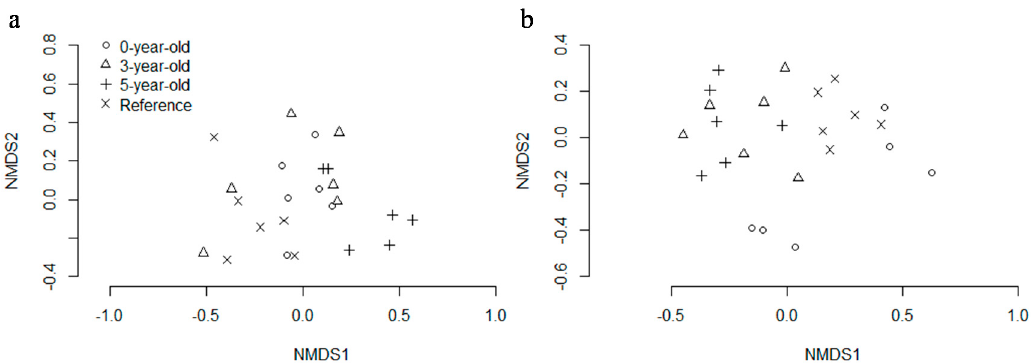
Figure 2. The NMDS ordination plot showing the species pollination traits in the ( a ) upland and ( b ) lowland areas. The NMDS was based on the Bray–Curtis similarity index computed using species abundance data.